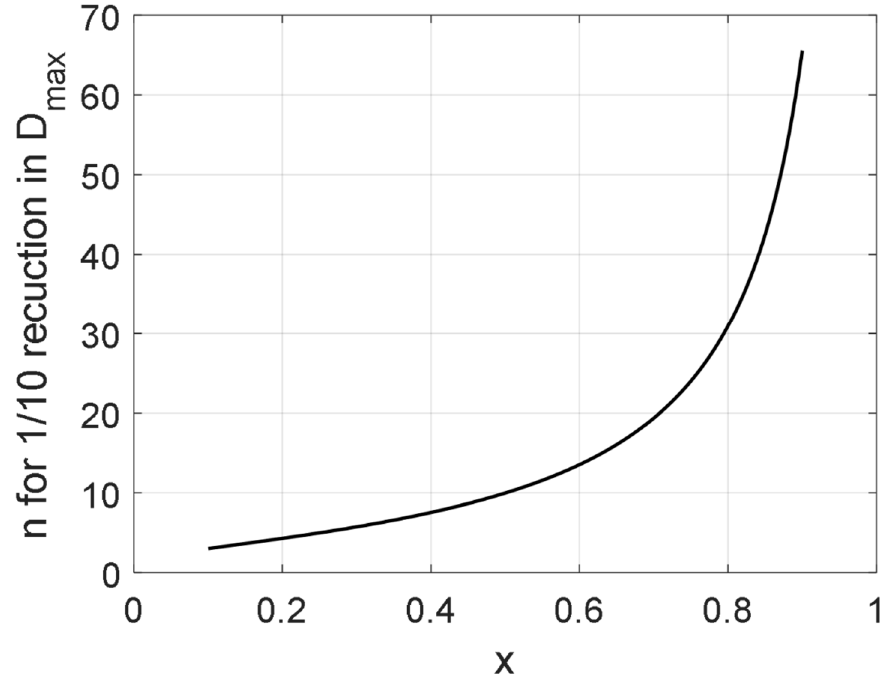
Figure 10. The number, n , of passages through a breakup region required to achieve a reduction of the maximum drop diameter D max by a factor 1:10, as a function of x , the drop volume fraction ending up in the largest fragment (Equation